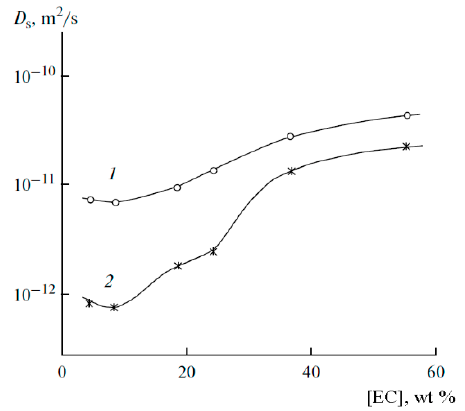
Figure 17. Dependences of the average self-diffusion coefficient of 1 H ( 1 ) and self-diffusion coefficient of 7 Li + ( 2 ) on the solvent concentration [53].